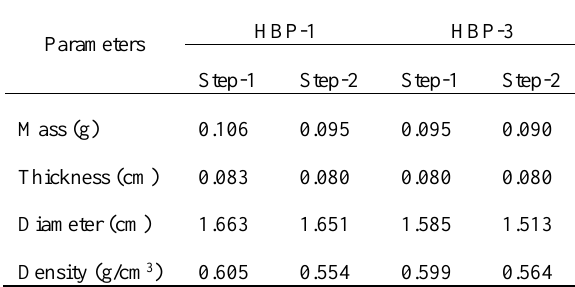
Table 1. Average mass, thickness, diameter and